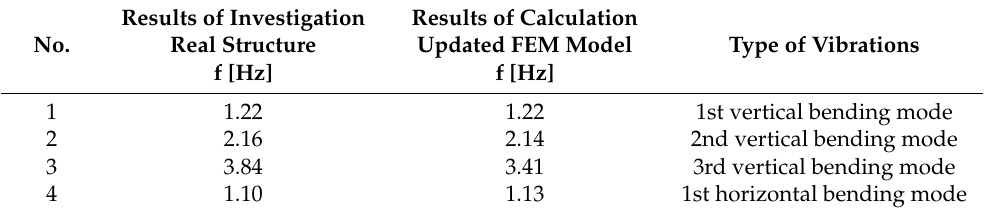
Table 2. Comparison of frequencies between the experiment and the updated FEM model.